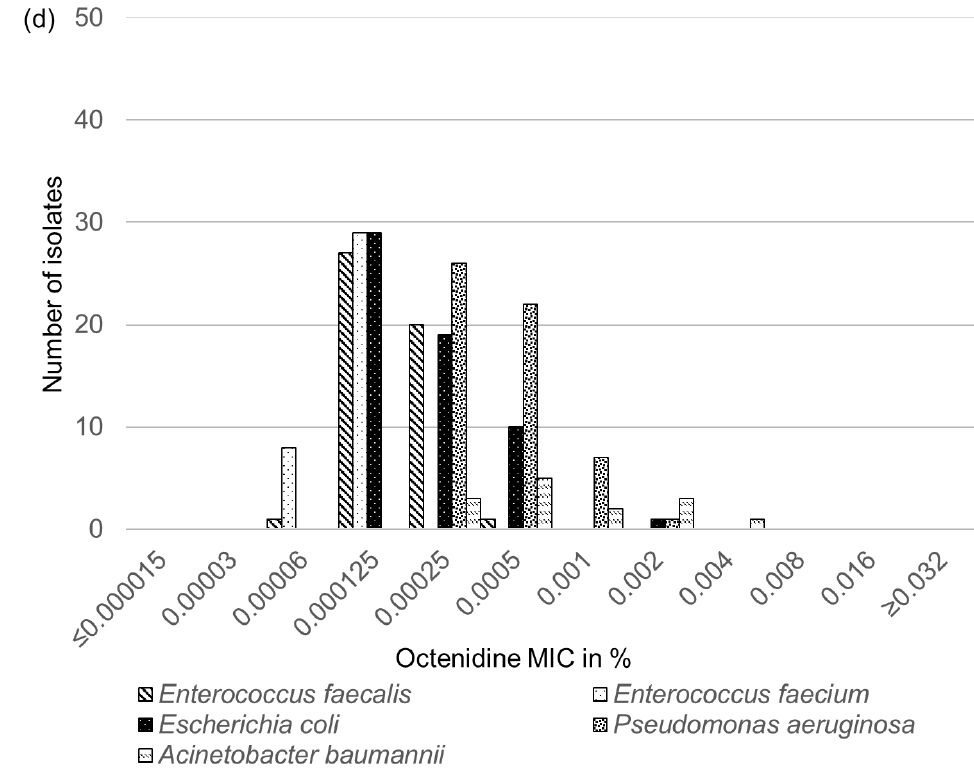
Figure 1. Distributions of the MIC values of the 49 E. faecalis , 37 E. faecium , 59 E. coli , 56 P. aeruginosa , and 14 A. baumannii isolates for the four biocides tested: ( a ) benzalkonium chloride, ( b ) chlorhexidine, ( c ) polyhexanide, and ( d ) octenidine.